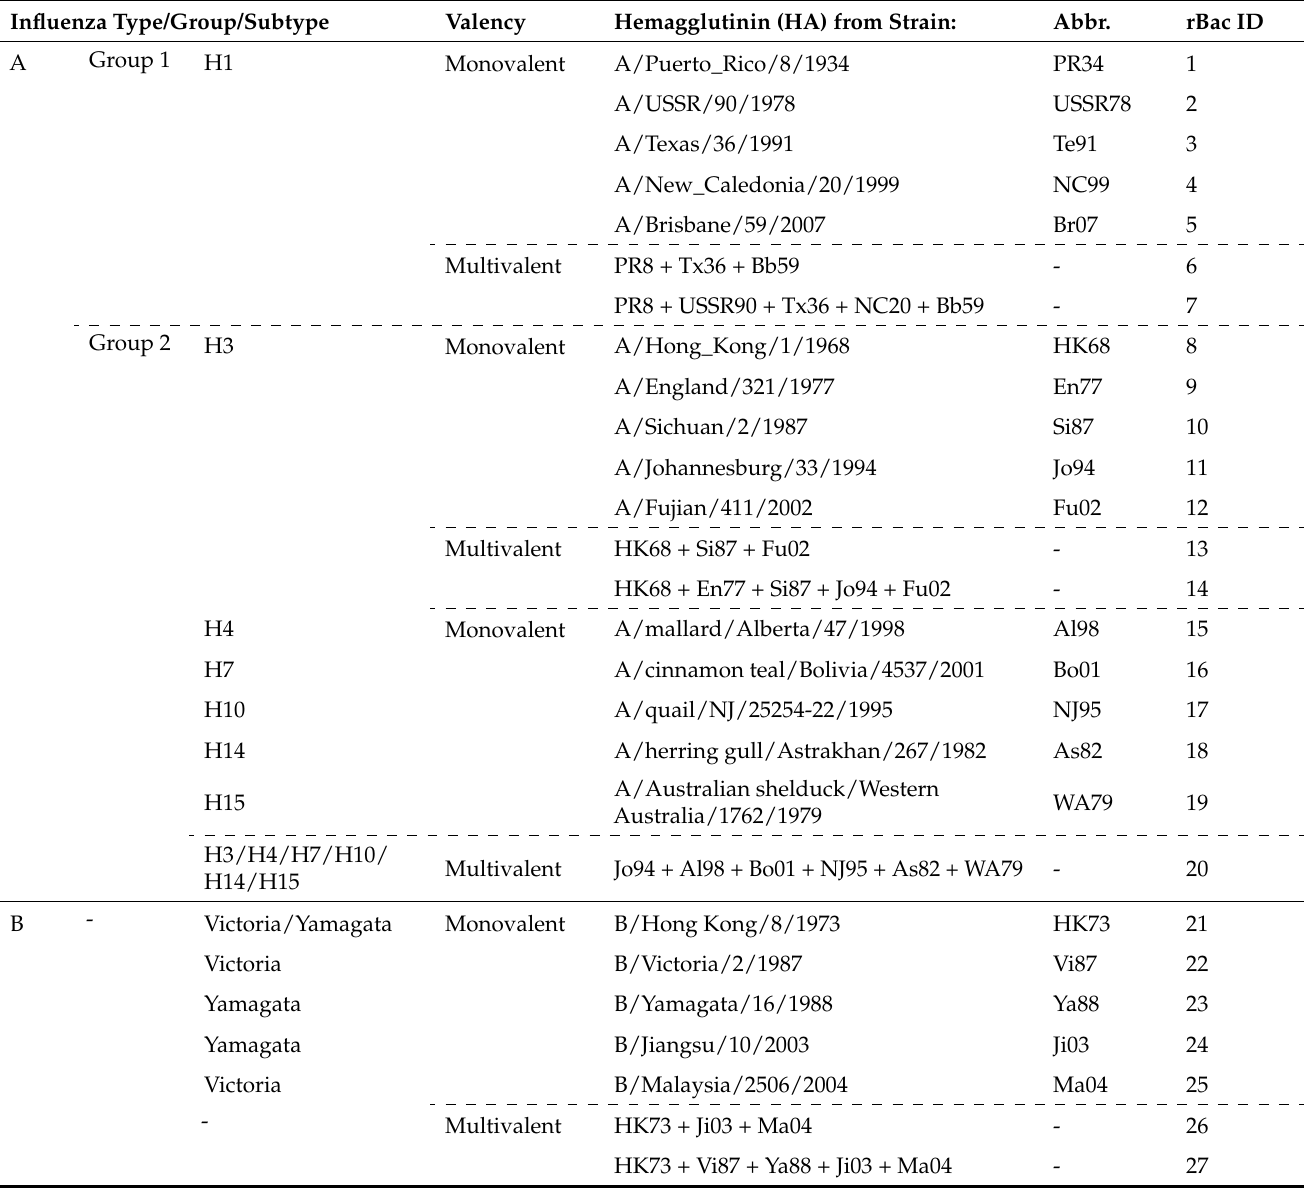
Table 1. List of recombinant baculovirus used for the production of influenza HA-VLPs at the 2 L bioreactor